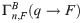
Decoding the stimulus class in single trials when the onset of a stimulus is known, subject 3.
(A) Squared cross-correlation values at each electrode. Training feature points were obtained by back-projecting the event triggered broadband, 〈B
n(t')〉F (see Methods), into the training data and comparing projected face, Γn,FB(q→F), and inter-stimulus interval (ISI), Γn,FB(q→o), points. These rn2 values are scaled by color, and plotted on an axial MRI slice with scaling shown in the colored bar beneath. The electrodes meeting acceptance criteria rn2>0.05 were selected as features for classification for the face template. (B) As in (A), but for house stimuli from the training period. (C) Event-triggered broadband templates from the training period for face, 〈B
1(t')〉F, and house, 〈B
1(t')〉H stimuli, from the electrode noted with a green arrow in (A-B). (D) As in (C), but from the electrode noted with an orange arrow. (E) Projection of event-triggered face template from (C) into testing data: The top black trace shows a portion of the broadband time course from the electrode noted with a green arrow, during the testing period, B
1(t). The 〈B
1(t')〉F face template is shown in light blue at each stimulus time, irrespective of class, at event testing times τ
p. The result of projecting the face template 〈B
1(t')〉F to B
1(t) is shown in the green background trace, Γ1,FB(t), with testing points at defined face stimulus times, Γ1,FB(p→F), shown with blue circles, and defined house stimulus times, Γ1,FB(p→H), shown with red circles. (F) As with (E), but for the orange-arrow electrode, B
2(t), and using the house template from (D), 〈B
2(t')〉H. (G) The subspace Γ1,FB vs Γ2,HB, is used to illustrate discrete classification approach. Here the back-projected training points Γn,SB(q) are shown with dots (blue for q → F and red for q → H), along with the testing feature points Γn,SB(p) shown with circles. One may see that a simple decision line (purple) in this subspace would result in only 1 error.